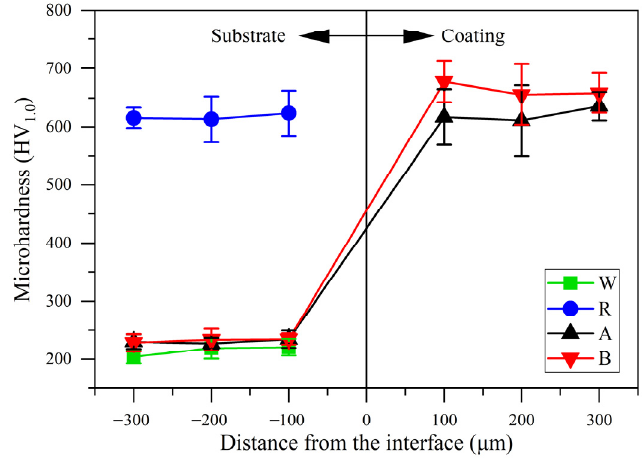
Figure 9. Microhardness of substrates and coatings.